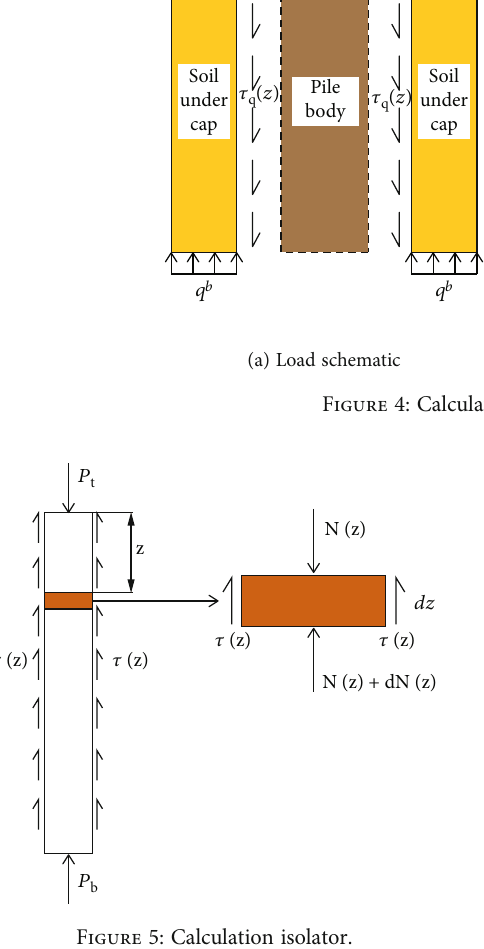
Figure 5: Calculation